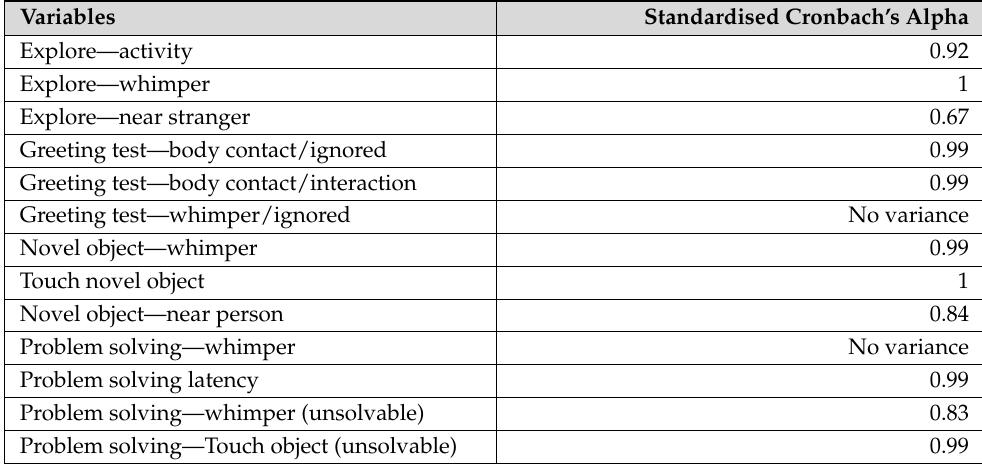
Table 5. Inter-rater reliability for durations.